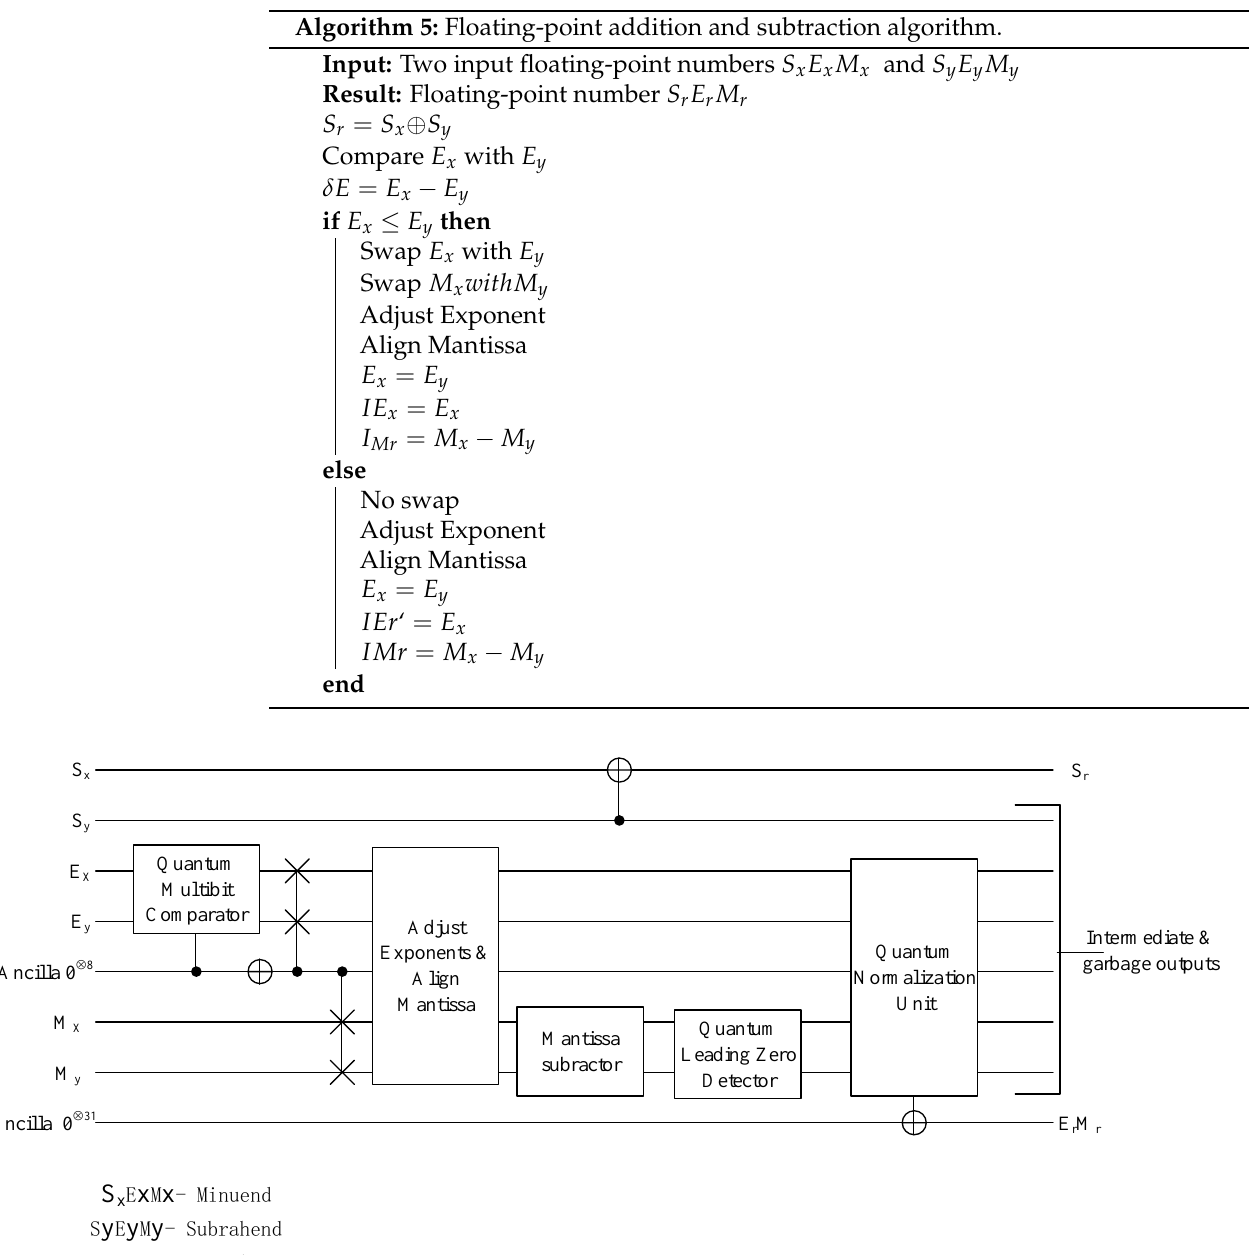
Figure 13. High level overview of proposed quantum subtractor circuit for a SPFP number. Intermediate outputs generated must be set back to the original state by running the compute block